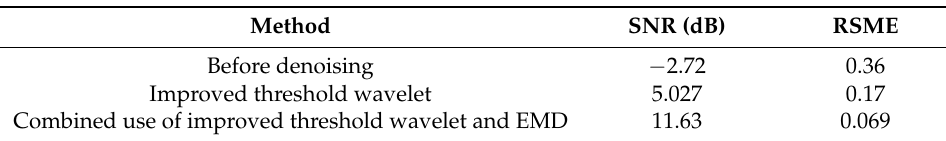
Table 2. Comparison of two denoising methods for joint signal. Table.2 Comparison of two denoising methods for joint signal.